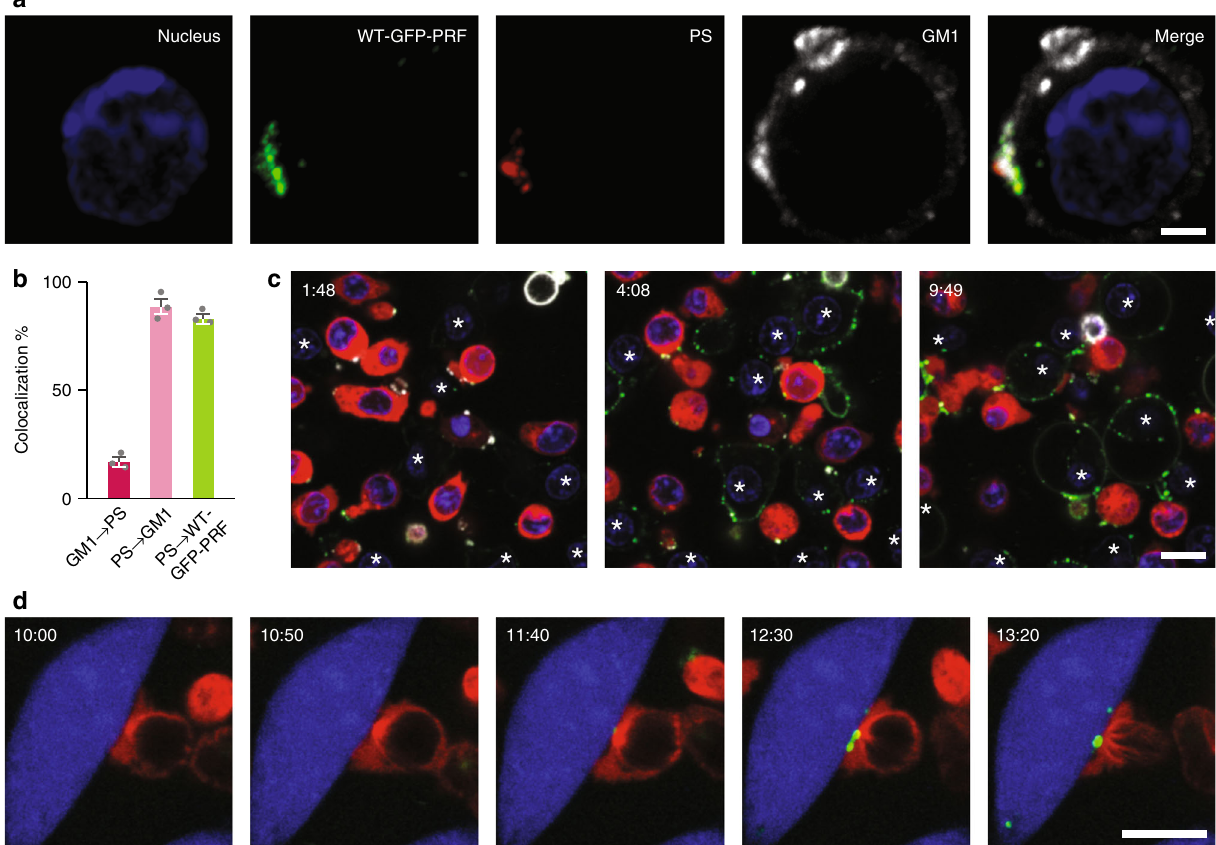
Fig. 7 Perforin binding to phosphatidylserine on the CTL plasma membrane. a Colocalization of GM1 (detected by cholera toxin subunit B-Alexa Fluor 647), externalized PS (detected by annexin V-Alexa 568) and recombinant WT-GFP-PRF (signal enhanced by GFP-TAG polyclonal antibody-Alexa 488) on a CTL. The nucleus (blue) is detected by Hoechst 34580. b Quantitative analysis (see Methods) of a shows low colocalization levels of GM1 with PS (17%) but high colocalization of PS with GM1 (88%) and PS with WT-GFP-PRF (83%). This indicates that the vast majority of PS is contained within lipid raft areas (whereas there are many lipid raft areas which do not contain PS) and more than 80% of this PS binds WT-GFP-PRF. Sixty-two cells were analysed, and the mean ± s.e.m. of three independent experiments is shown for each condition. Source data are provided as a Source Data fi le. c Montage of time- lapse confocal microscopy (Supplementary Video 1). WT-GFP-PRF (green) was added at 1:17 min to a mixture of CTLs transduced with cherry-tubulin (red) and EL4 cells (white asterisks). Hoechst 33342 staining (blue) shows the nucleus of both cell types. Annexin V-Alexa 647 (white) was maintained in the culture medium throughout the assay; it binds to PS exposed on the CTLs and to PS on and within EL4 cells that are exposed to cytotoxic levels of perforin and that lose membrane integrity. EL4 cells are seen to bind WT-GFP-PRF uniformly before gradually becoming annexin V positive, whilst perforin on the CTL membrane localizes precisely (and almost immediately) to regions of exposed PS, without lysing the CTLs (Supplementary Video 2). d Montage of time-lapse confocal microscopy (Supplementary Video 3) reveals a bright punctate region of PS (detected by annexin V-Alexa 488 maintained during assay; shown in green) exposed on the CTL membrane during synapse formation. Cell Trace Violet labelled target cells (MC57, shown in blue) were labelled with SIINFEKL and synapse formation is con fi rmed by the docking of the centrosome (detected by cherry-tubulin expressed in the Prf1 − / − CTL; shown in red) at the point of contact between CTL and target. Timestamps in c and d are in minutes. Scale bars: a , 2 µ m; c , d , 10 µ